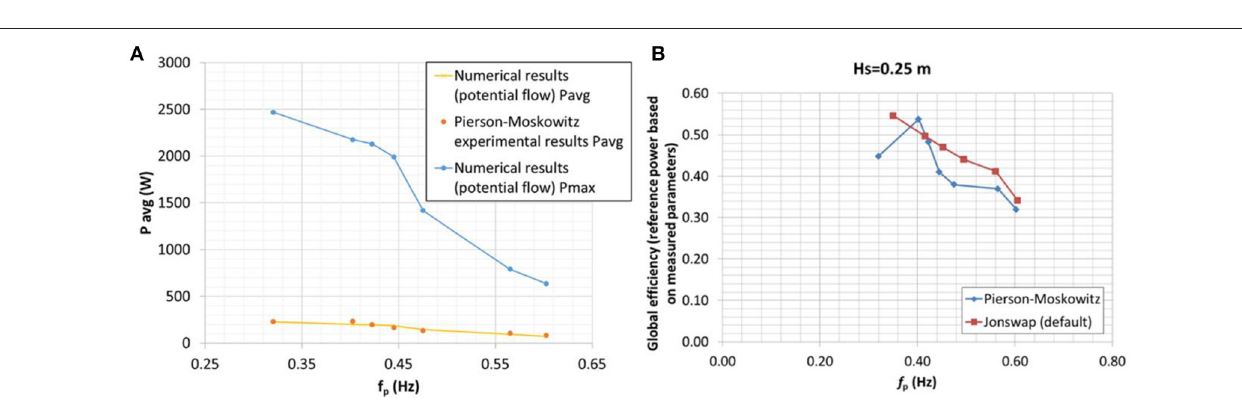
slight reduction of performance with respect to the regular sea state